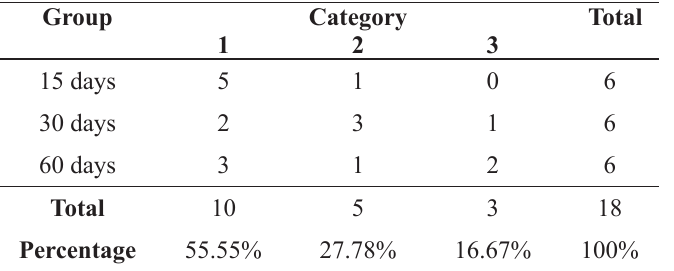
TABLE 1 - Number of animals per type of tissue found in the bone defect using categories according to the period of